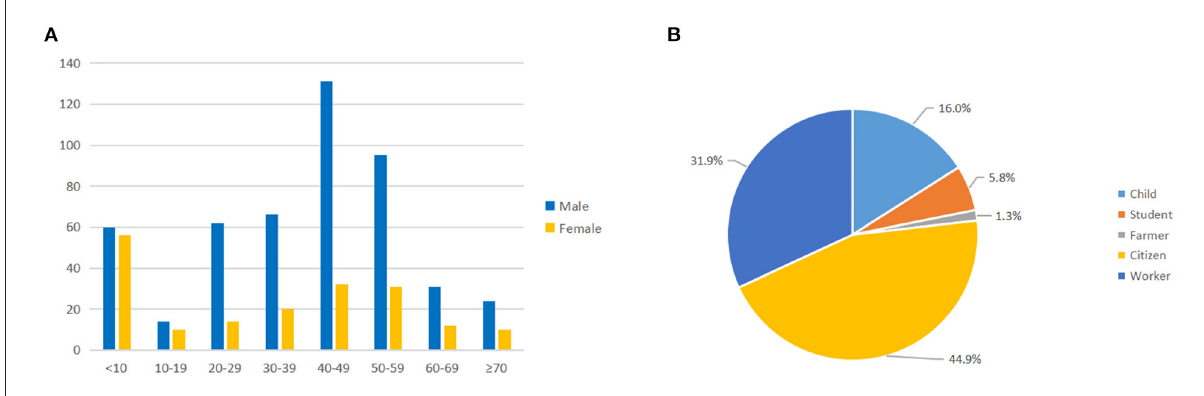
FIGURE1 Age (A) and occupation (B) distribution of patients with severe